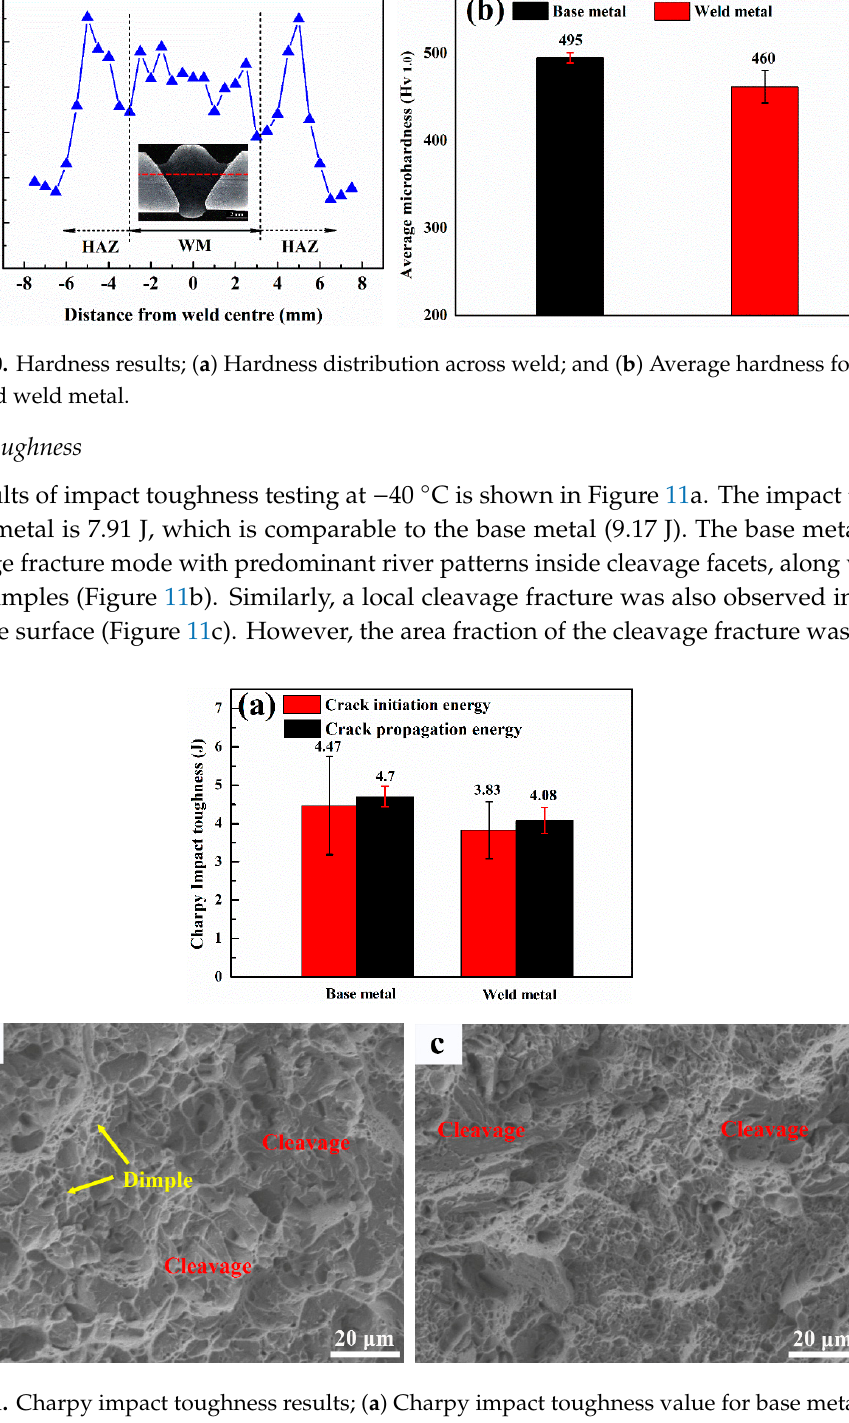
Figure 11. Charpy impact toughness results; ( a ) Charpy impact toughness value for base metal and weld metal; and ( b ) and ( c ) SEM images of fracture surface of base metal and weld metal,